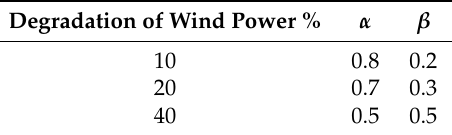
Table 7. Self-configuration of weighting parameter according to degradation of the wind